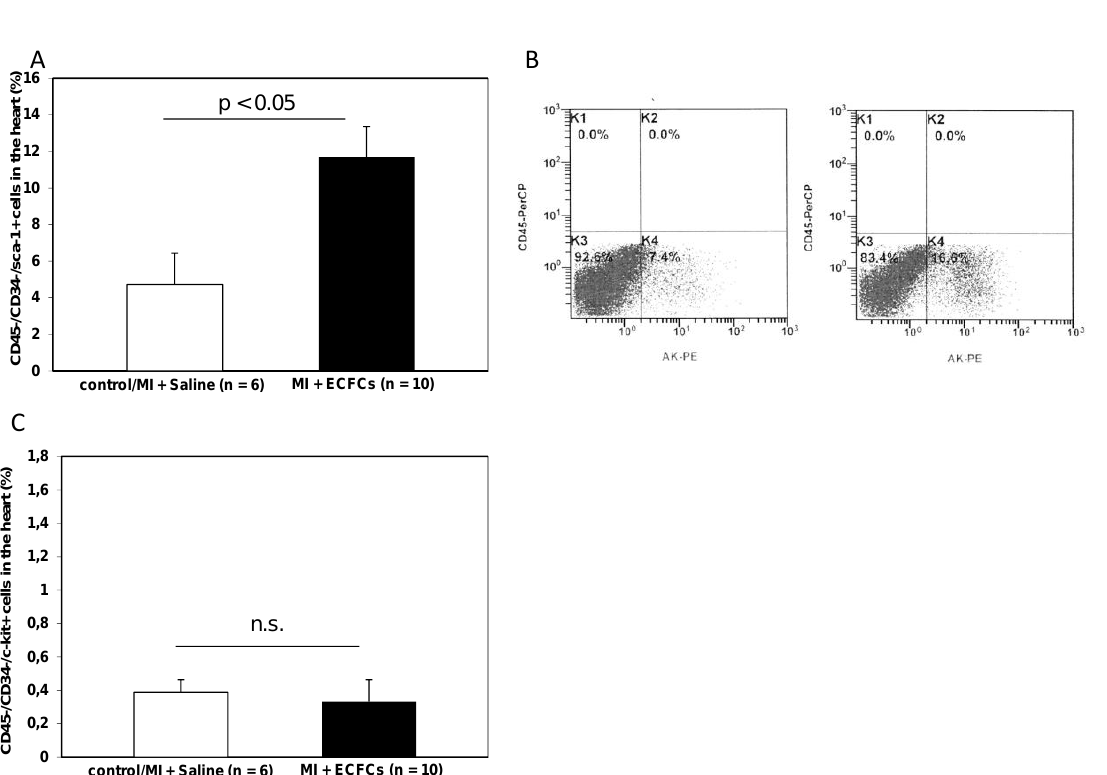
Figure 5. Increased numbers of Sca-1 + resident cardiac stem cells after ECFC injection into ischemic myocardium. ( A ) Bar graphs representing the percentage of Sca-1 + resident cardiac stem cells in the ischemic hearts of control animals (white bar) and after ECFC transplantation (black bar) 2 days after MI. Data represent mean ± SEM. ( B ) Representative FACS analyses of Sca-1 + resident cardiac stem cells in the heart of control animals (left) and after ECFC transplantation (right) 2 days after MI. ( C ) Bar graphs representing the percentage of c-kit + resident cardiac stem cells in the ischemic hearts of control animals (white bar) and after ECFC transplantation (black bar) 2 days after MI. Data represent mean ± SEM; n.s., not significant.